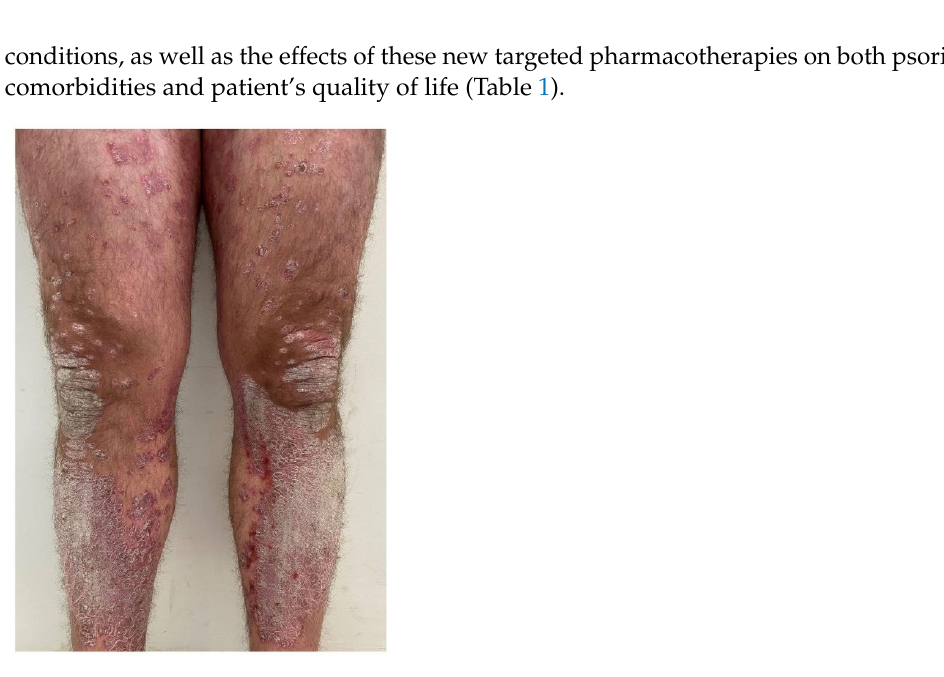
Figure 1. Plaques of psoriasis affecting the extensor surface of lower limbs in a 42-year-old male patient. Table 1. Targeted pharmacotherapies exerting a possible “disease modification effect” in chronic plaque psoriasis.